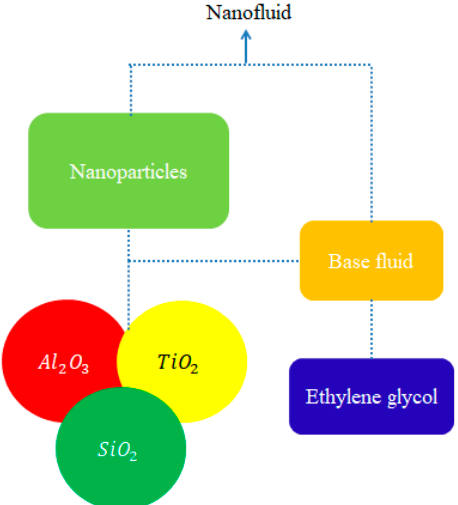
Figure 1. Prepared scheme of hybrid nanostructures.